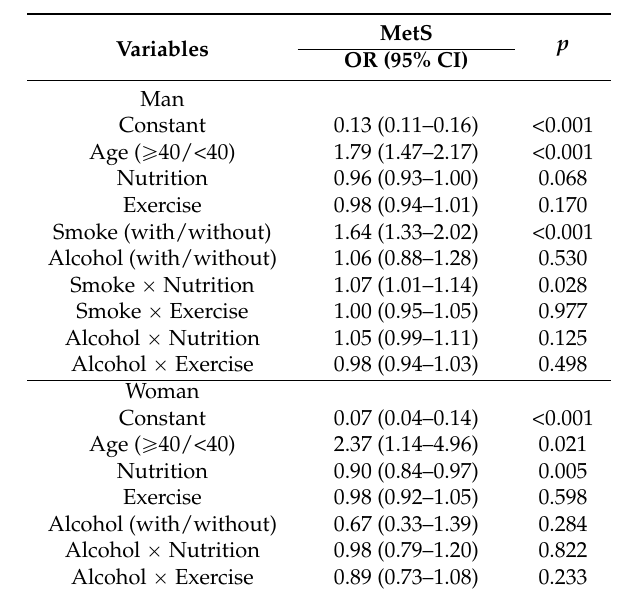
Table 4. Interactions between smoking/alcohol habits and exercise/nutrition behaviors on the risk of